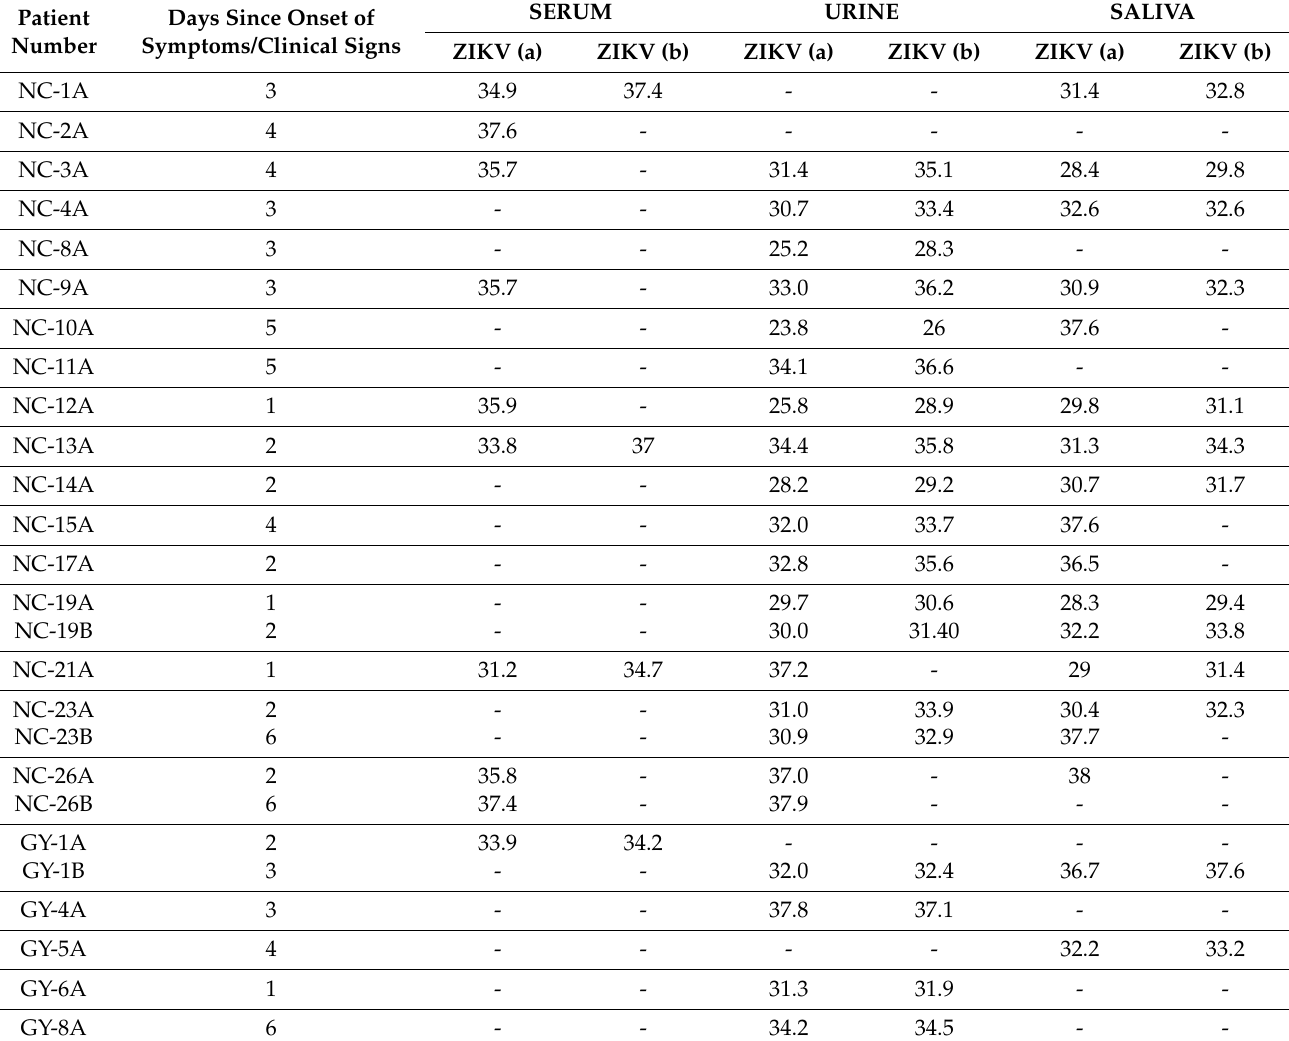
Table 1. RT-qPCR diagnostic results from patients presenting symptoms and clinical signs associated with arbovirus